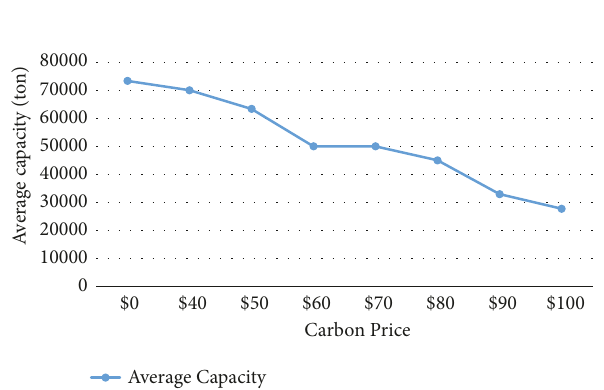
Figure 5: Average size of plants with carbon price